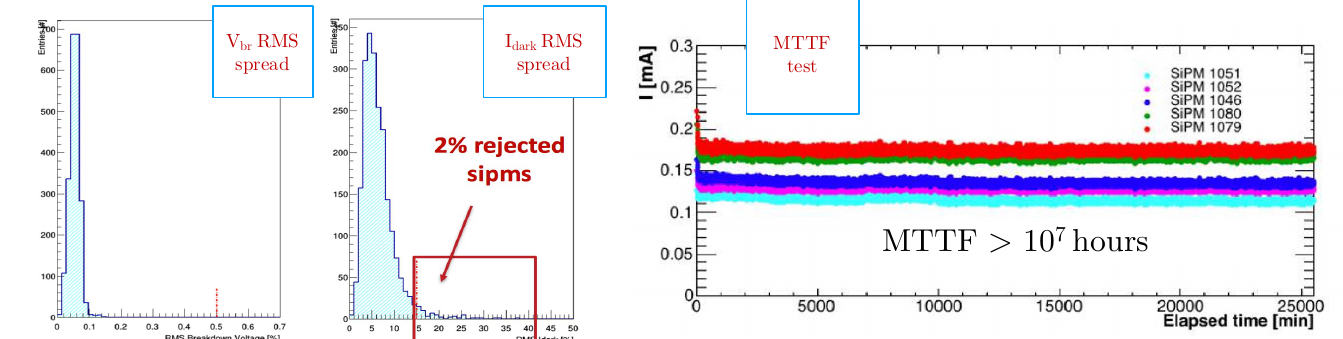
Figure 5. Summary of breakdown voltage ( left ) and dark current ( centre ) RMS spread in production lots. Summary of MTTF tests on production SiPMs ( right ): dark current as a function of elapsed operating